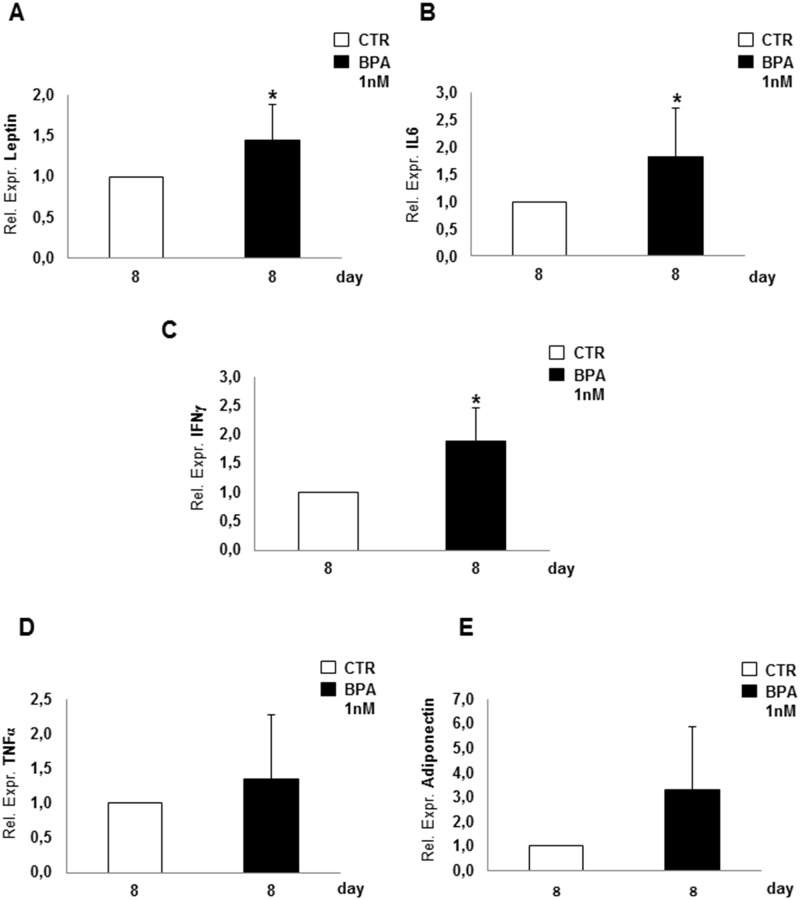
Pro-inflammatory effect in 3T3-L1 mature adipocytes.In mature adipocytes, mRNA levels of Leptin (A), IL6 (B), IFNγ (C), TNFα (D) and adiponectin (E) were assayed at day 8, the end of adipogenesis, by Real-time RT-PCR analysis, and expressed as Relative Expression Unit (REU). Bars represent the mean ± SD of four independent experiments. Asterisk indicates statistically significant difference (*p<0.05) between adipocytes cultured upon BPA treatment compared to controls.